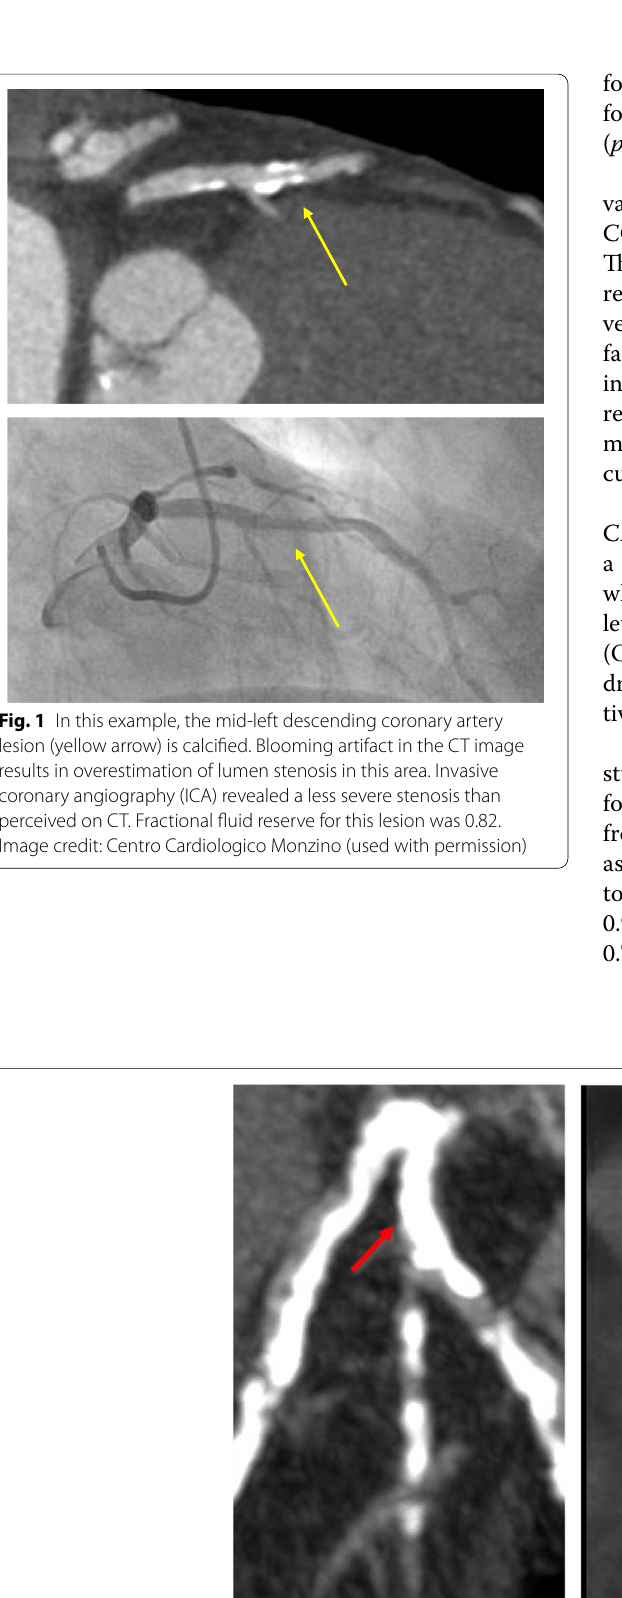
Fig. 2 In this example, the proximal part of the left circumflex coronary artery (LCx) has heavy uniform calcification, resulting in blooming in the CT image. This results in the inability to distinguish the severe ostial LCx stenosis (red arrow), that is easily identified using